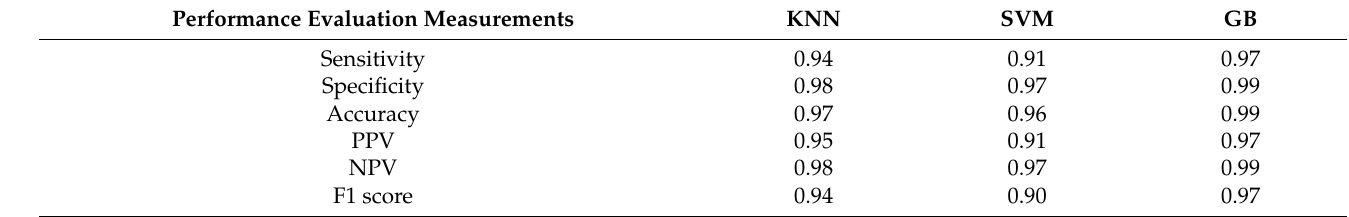
Table 5. Hyper-parameters obtained using a specific number of videos for the ( a ) KNN, ( b ) SVM and ( c ) GB